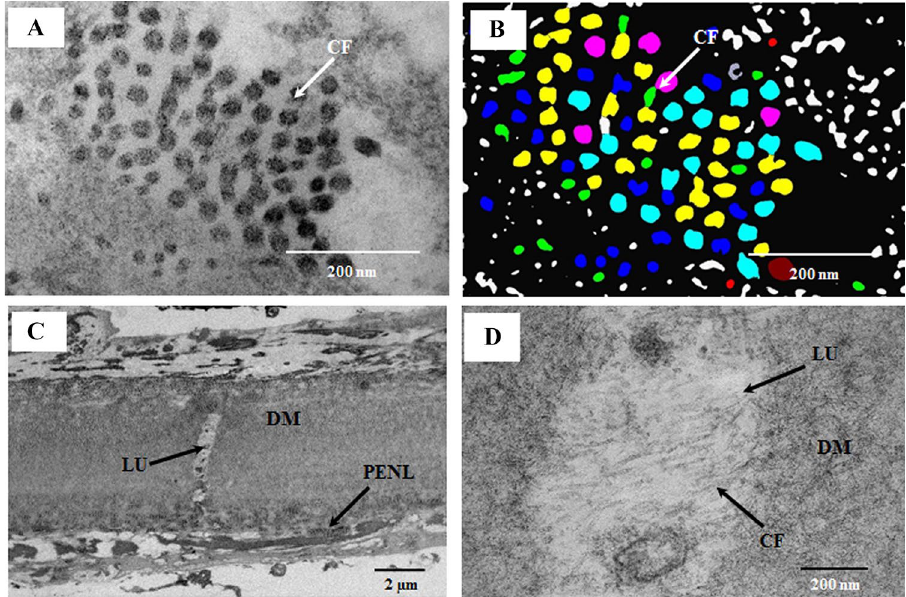
Figure 3. Electron micrographs illustrate the fibers of the pre-endothelial layer (PENL), pre-Descemet’s membrane layer (PDL), and Descemet’s membrane (DM). ( A ) Part of the PENL containing collagen fibrils (CFs) near the endothelium (EN). ( B ) Digital color-coded image of CFs showing fibrils ranging from 15 to 45 nm in diameter. ( C , D ) Part of DM containing electron-lucent space that includes CFs. CF collagen fibril, DM Descemet’s membrane, LU lucent space, PENL pre-endothelial layer. Red, 15–20 nm; green, 20–25 nm; blue, 25–30 nm; yellow, 30–35 nm; terracotta, 35–40 nm; orange, 40–45